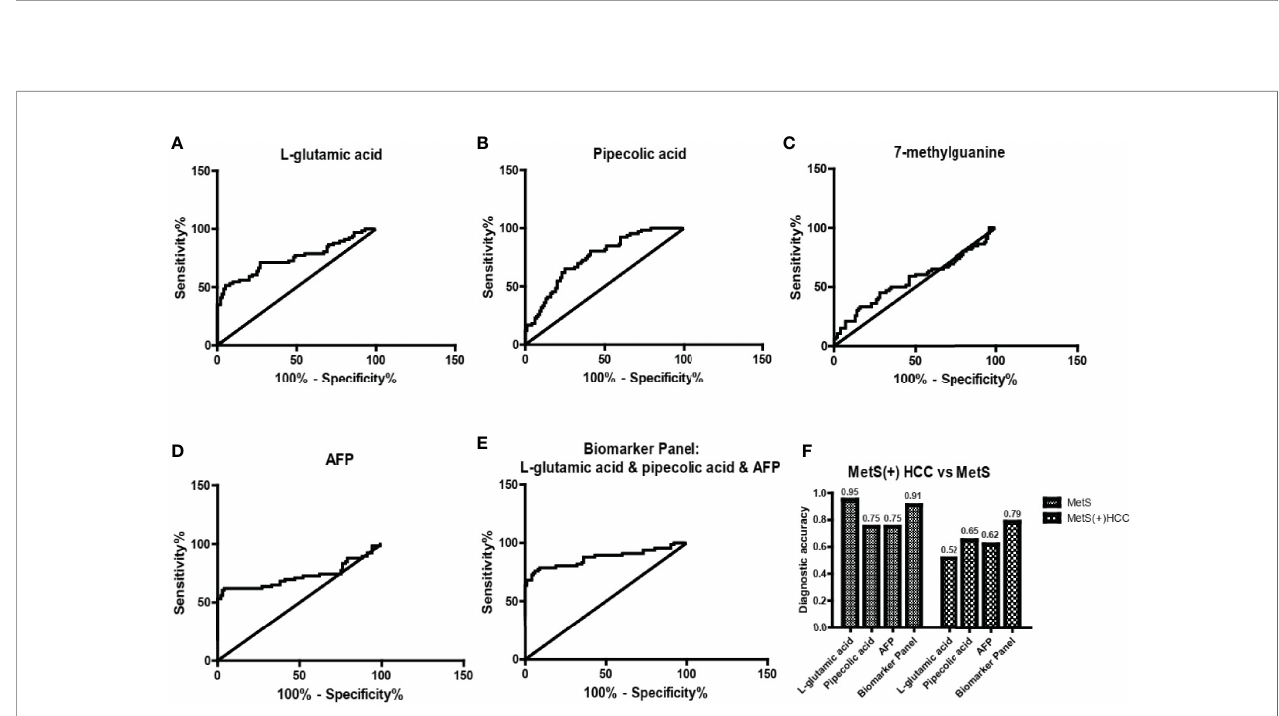
FIGURE 4 | The diagnostic performance of L-glu, PA and 7-mG. (A) The ROC curve of L-glu for discriminating MetS(+) HCC from MetS. (B) The ROC curve of PA for discriminating MetS(+) HCC from MetS. (C) The ROC curve of 7-mG for discriminating MetS(+) HCC from MetS. (D) The ROC curve of AFP for discriminating MetS(+) HCC from MetS. (E) The ROC curve of the biomarker panel including L-glu, PA and AFP for discriminating MetS(+) HCC from MetS. (F) The diagnostic accuracy of L-glu, PA, AFP and the biomarker panel for the diagnosis of MetS and MetS(+) HCC, respectively. ROC, receiver operating